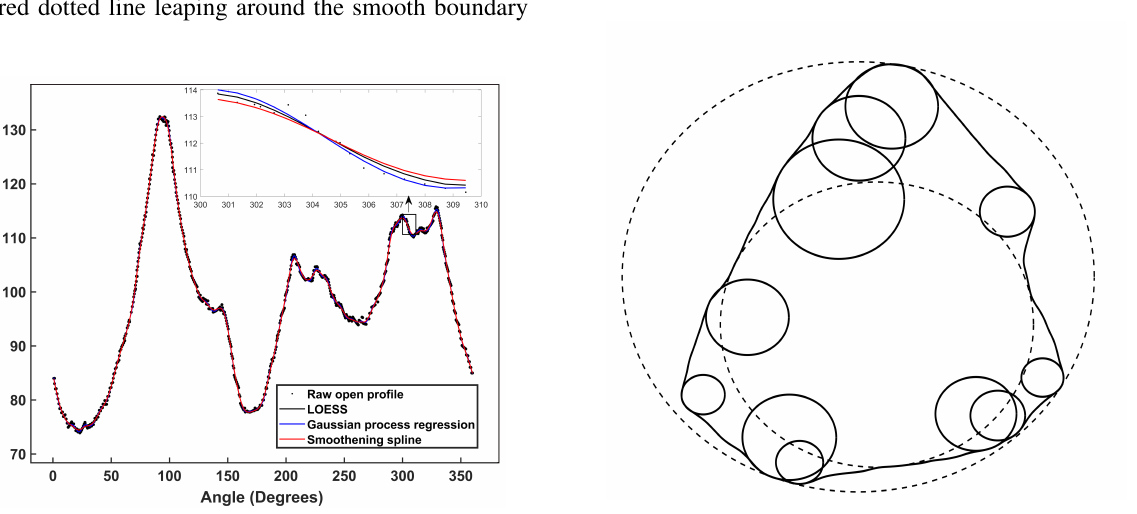
Figure 4: Convex corners fitted with